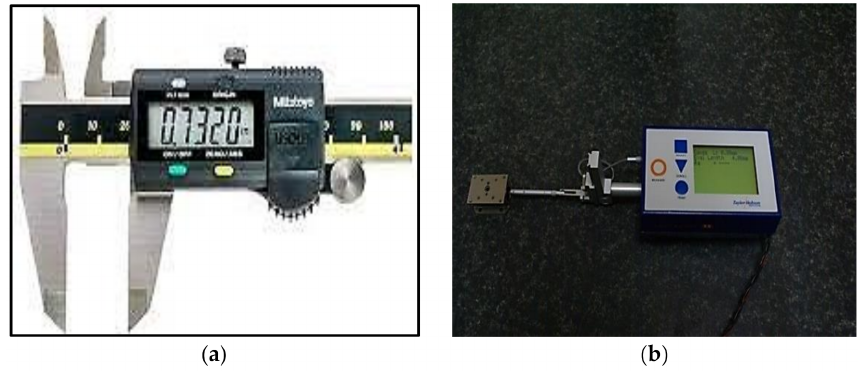
Figure 2. ( a ) Digital Vernier calliper ( b ) Taylor Hobson SURTRONIC 25 machine. Surface Roughness ( Ra )—Taylor Hobson SURTRONIC 25 machine, accuracy of 2% of reading + LSD (least-significant digits) µ m (Make: AMETEK, Country: Chennai,